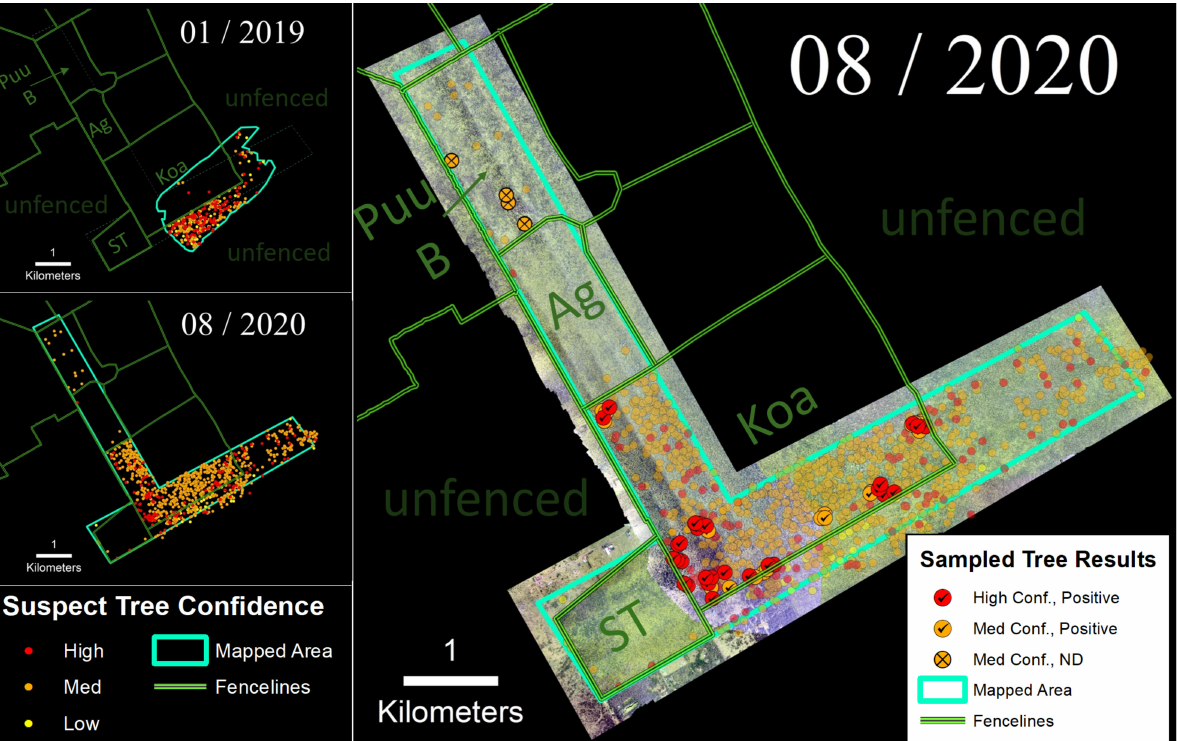
Figure 6. ( Left ) Time-series sequence of suspect trees for the ‘ ¯Ola‘a tract of Hawai‘i Volcanoes National Park. ( Right ) Sam- pled trees and corresponding laboratory results; non-sampled suspect trees appear as semi-transparent background